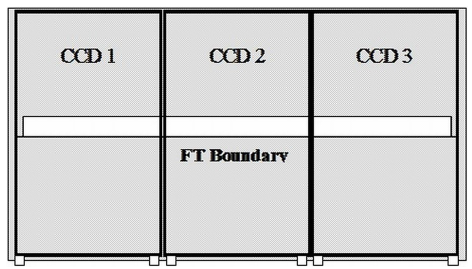
Figure 3: Schematic showing the region on the CCD where time resolved RSS spectra are recorded using a focal plane mask together with the spectrograph slit. Spectra of the target and sky are obtained in the rect- angular region, which shuffled down across the frame transfer boundary at the end of a short exposure.